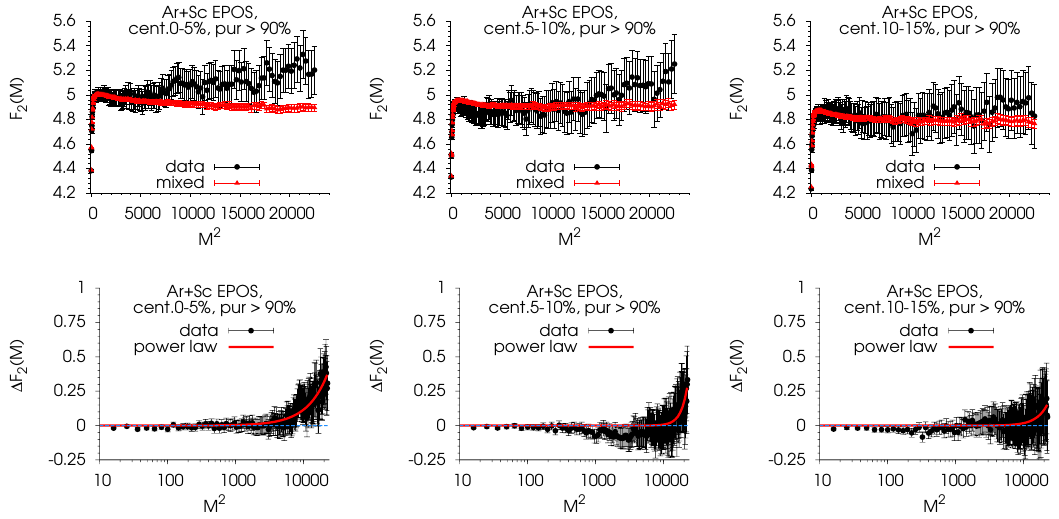
Figure 4. ( Top row ) F 2 ( M ) of original (filled circles) and mixed events (filled triangles) for EPOS Ar + Sc collisions at 0–5% (left), 5%–10% (middle) and 10%–15% (right) centrality at 150 A GeV/ c √ s NN = 16.8 GeV). ( Bottom row ) ∆ F e ( guide the eye and correspond to power-law scaling functions, ∆ F e